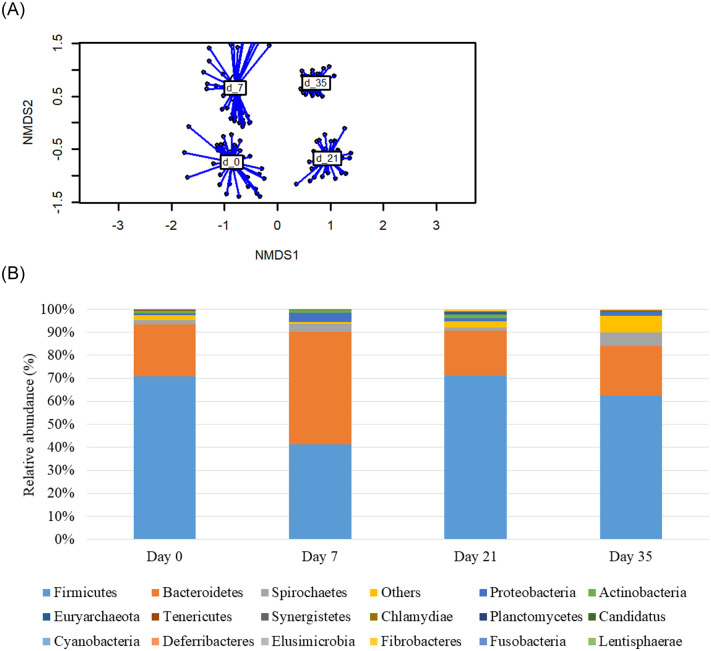
Effect of age on beta diversity, represented in the non-metric multi-dimensional scaling (NMDS) plot (A) and on the relative abundance of phyla (B) of fecal samples from piglets at 0, 7, 21 and 35 of the study.Mean values were obtained from 1 animal per replicate from each treatment on each sampling day.